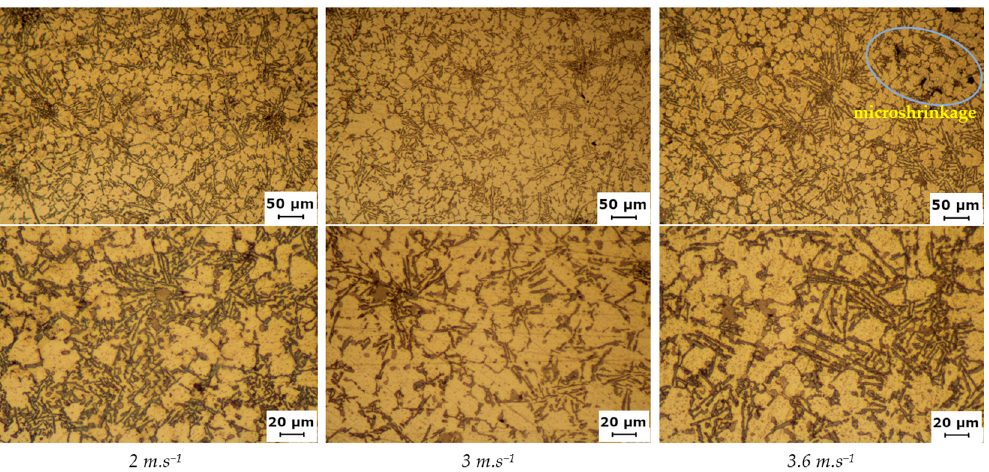
Figure 10. Micrographs of the SB 55 variant tube parts at 200 and 500× magnification.